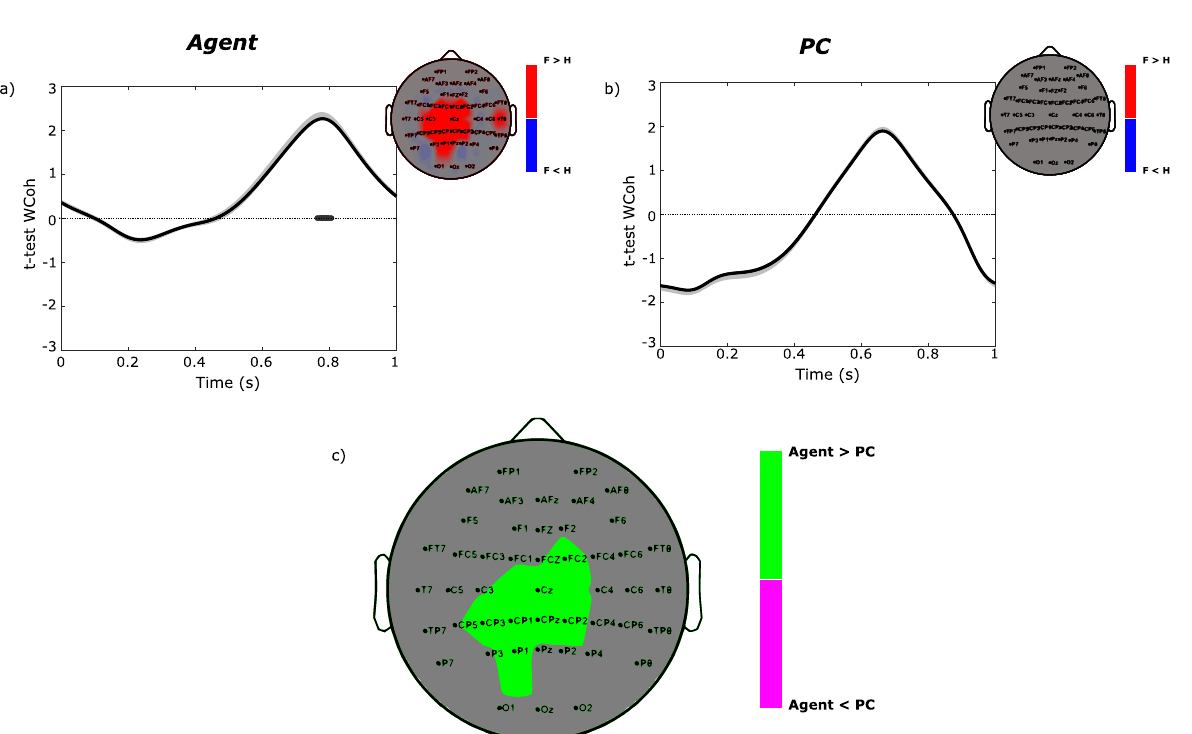
Figure 2. ( a , b ) Diagrams reporting the time course of t-values and the related 95% confidence interval obtained comparing the receiver–observer wavelet coherence in fair (F) and hyperunfair (H) conditions at Pz location, for the Agent ( a ) and PC ( b ) conditions. The dark grey line over the x-axis indicates the interval in which wavelet coherence is statistically different between fair and hyperunfair conditions (paired t-test, alpha = 0.05 validated by means of Guthrie–Buchwald method). Scalp maps reported in the upper-right part of each panel refer to the spatial distribution of wavelet coherence at the LPP peak. The maps are seen from above, with the nose pointing to the upper part of the page. Colormap codes for the significant t-values obtained comparing wavelet coherence in fair and hyperunfair conditions within the group (paired t-test). ( c ) Scalp map computed at LPP peak latency reporting the significant t-values obtained comparing the receiver–observer wavelet coherence in Agent and PC conditions (paired t-test, alpha = 0.05). We performed the comparison Agent (fair VS hyperunfair) VS PC (fair vs